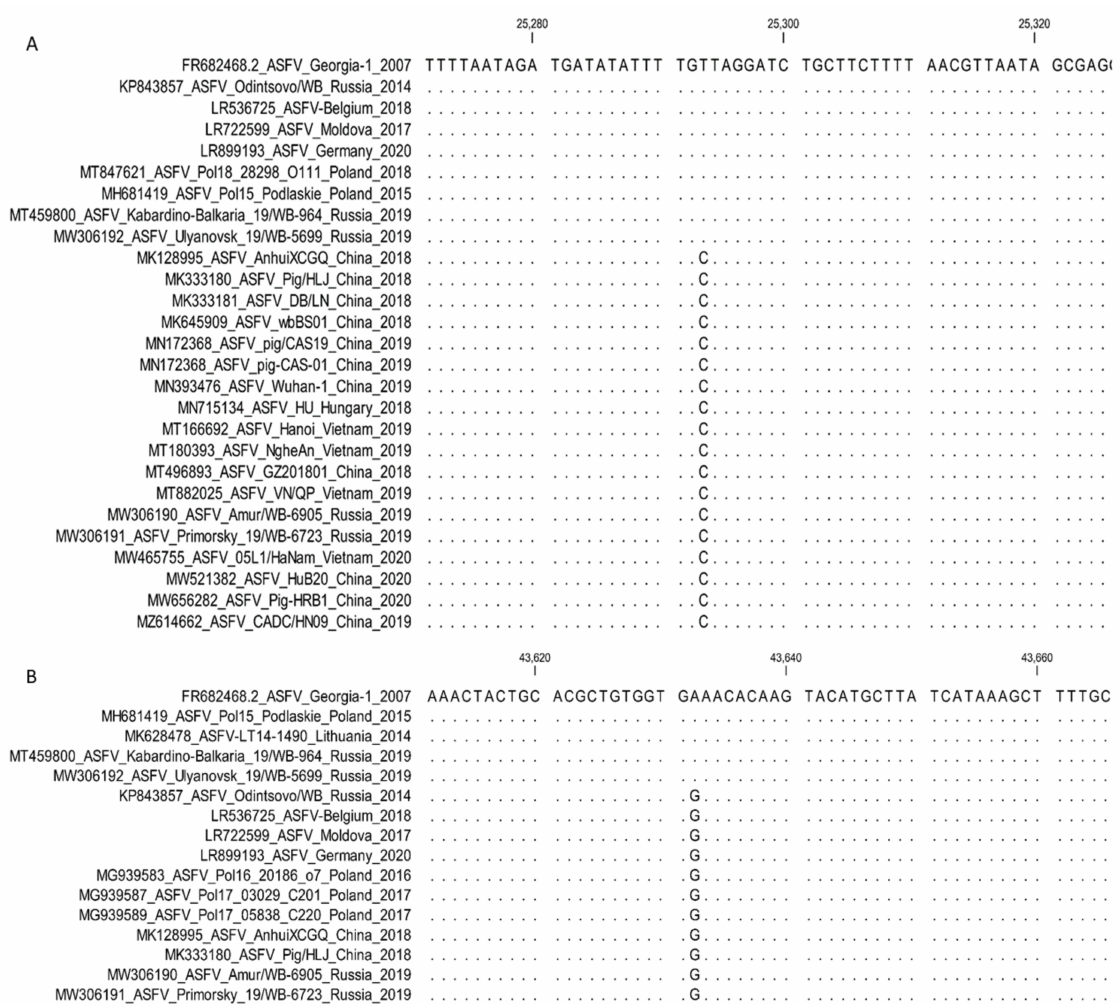
Figure 10. Nucleotide sequence alignment of ASFV samples using the partial ORFs MGF-360-10L ( A ) and MGF-505-9R ( B ) genes. A. The T-to-C substitution in the MGF-360-10L gene at position 677 from the starting codon of the gene. B. An A-to-G substitution in the MGF-505-9R gene at position 967 from the starting codon of the